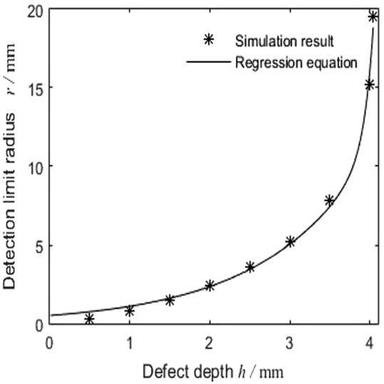
Detection limit radius vs. defect depth.